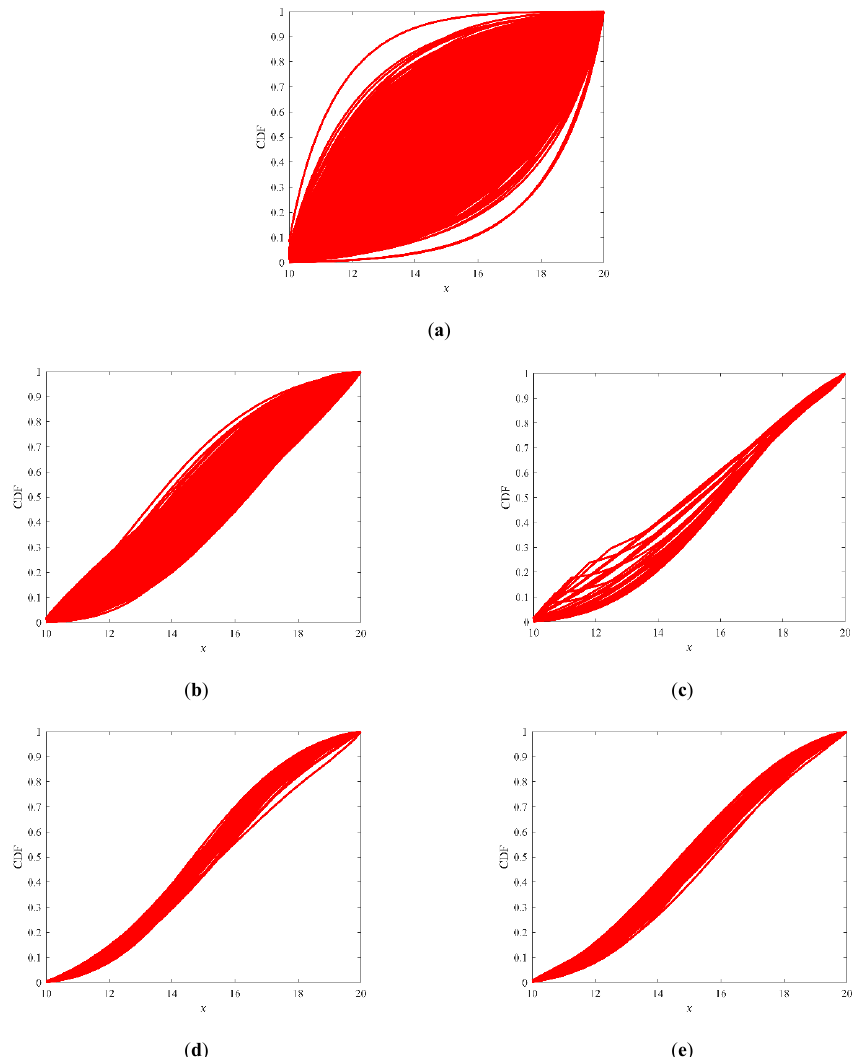
Figure 6. Cumulative probability density function of epistemic uncertainties ( a ) Case 1; ( b ) Case 2; ( c ) Case 3; ( d ) Case 4; ( e ) Case 5.